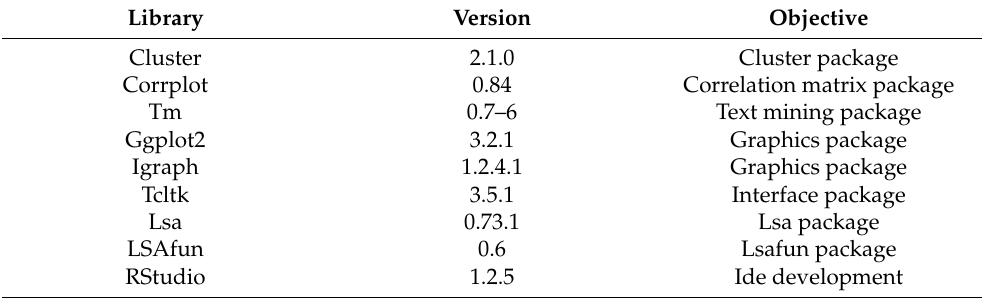
Table 1. Open-source software used for text mining. The library, version and its objective are shown.